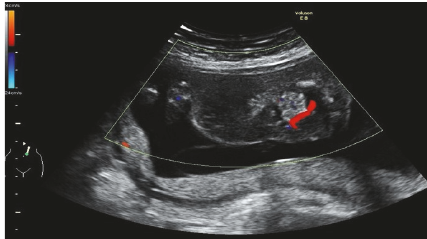
Figure 1: Ultrasonic color Doppler image of the acardiac fetus at 16 weeks of gestation. Blood flow is observed in the navel of the acardiac fetus, which is stuck to the anterior uterine wall. Complete cessation of blood flow in the acardiac fetus was successful with a single puncture.